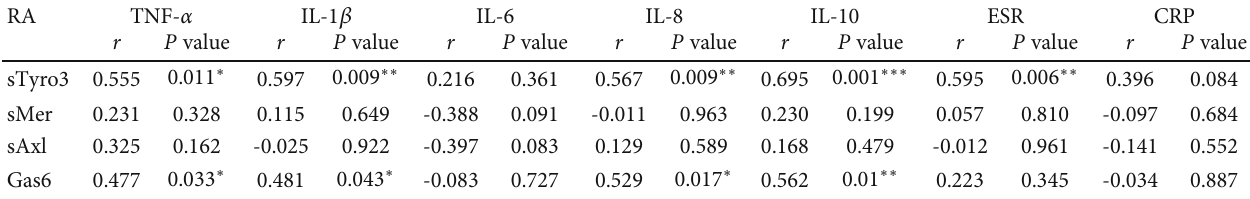
Table 2: Relationship between soluble TAM receptor levels and local and systemic in fl ammatory